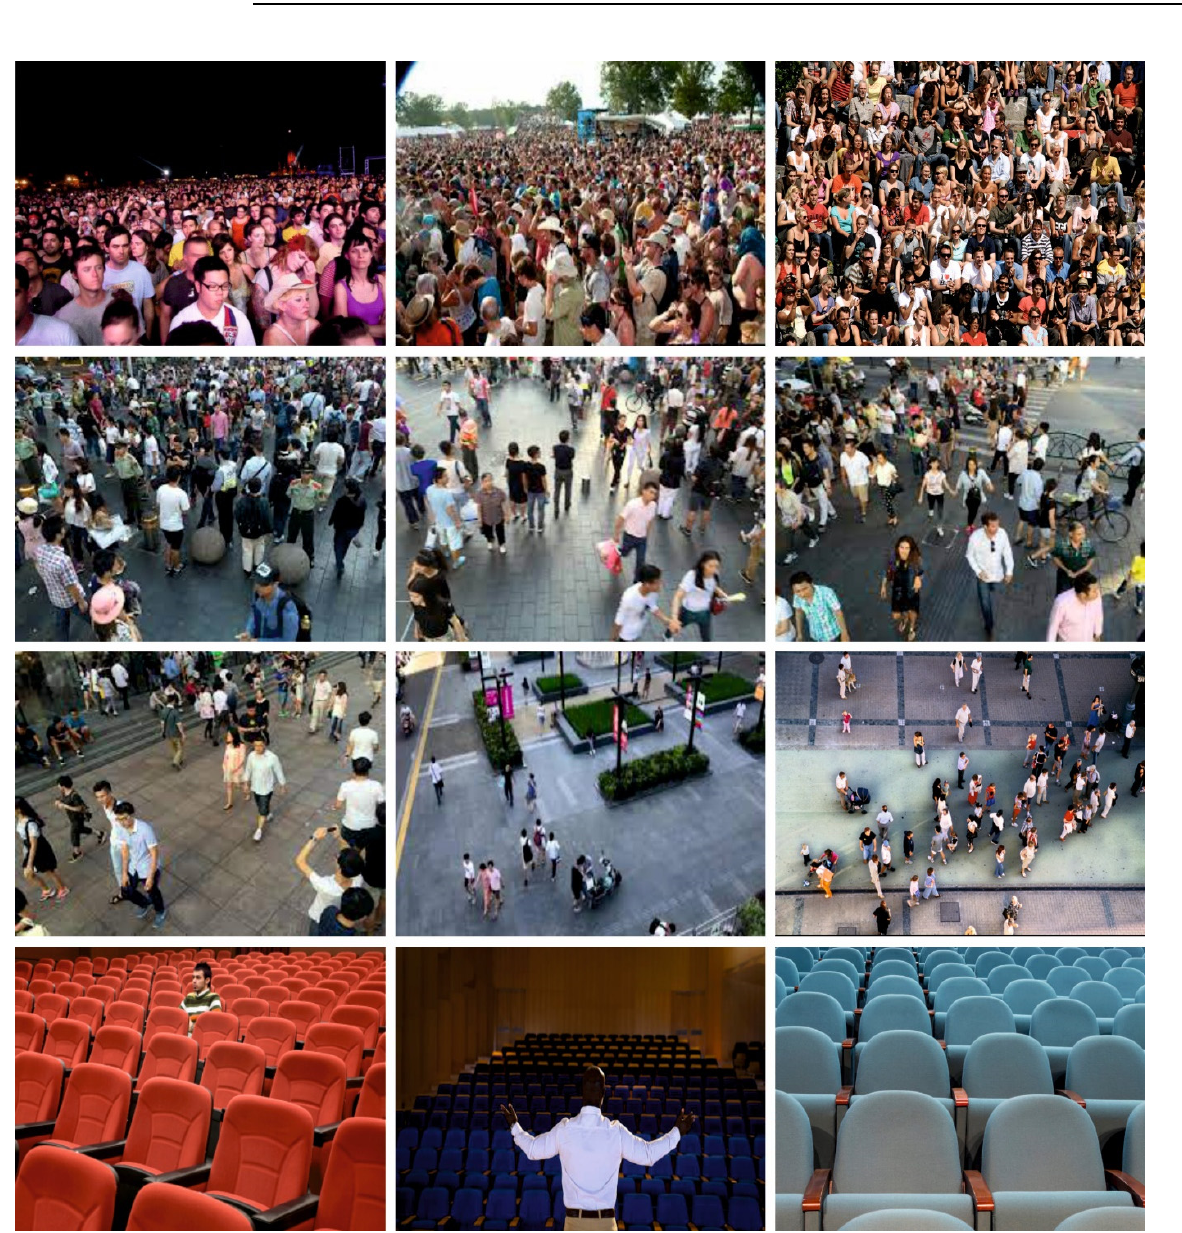
Figure 2. Sample images.